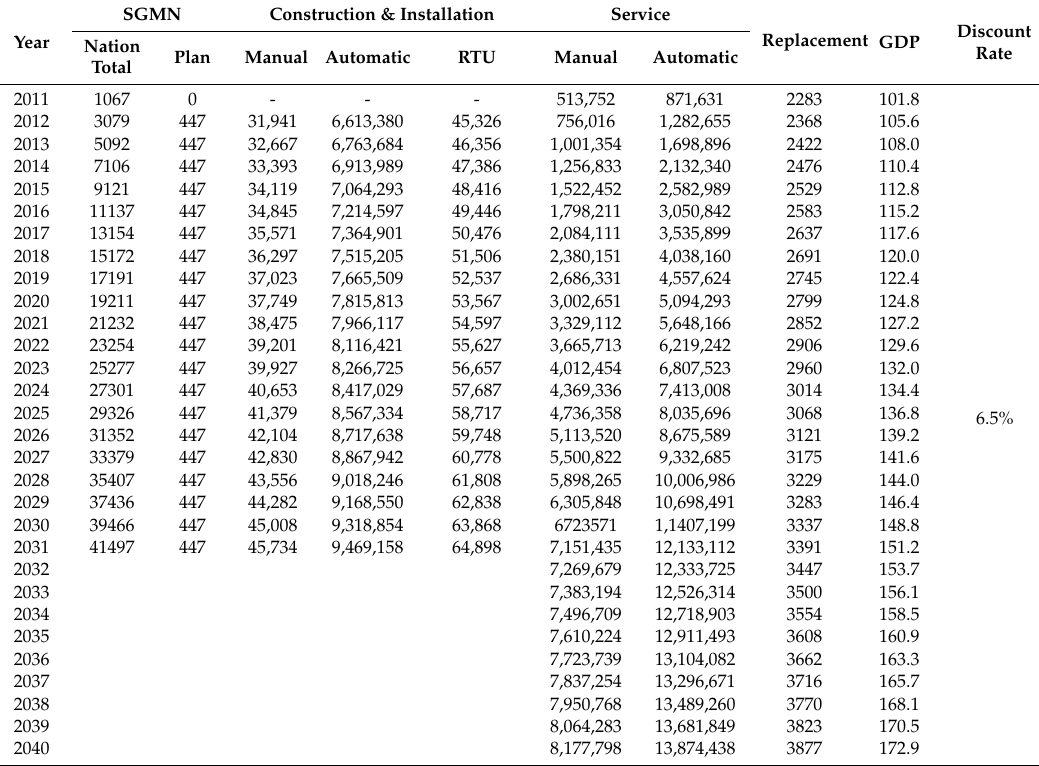
Table A2. Cost detail of the SGMN (unit: